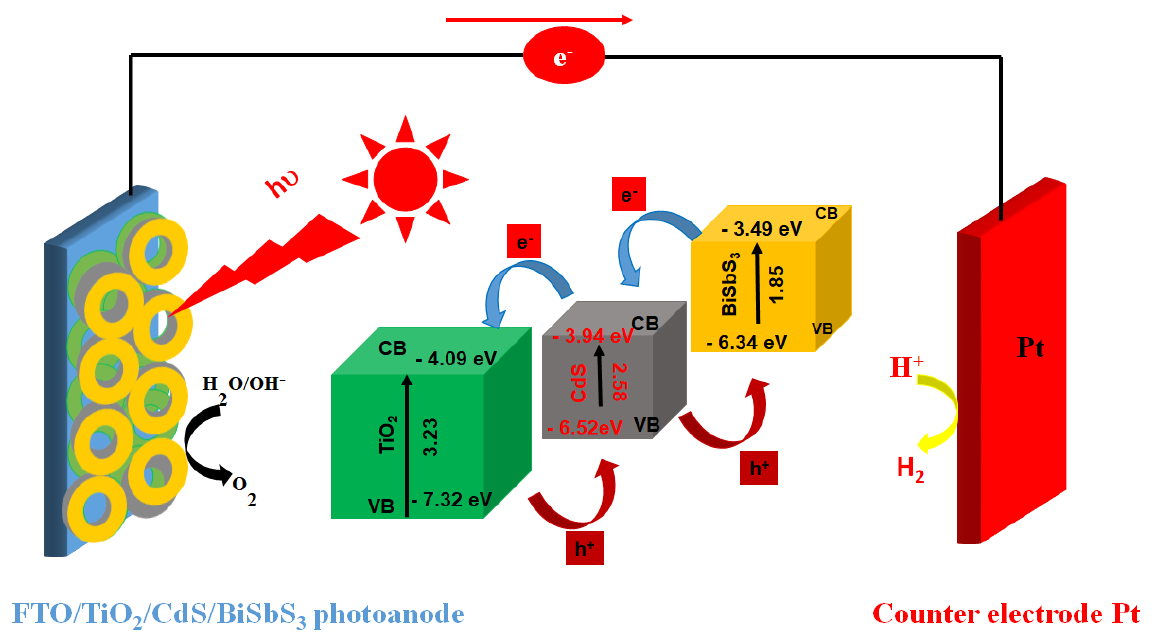
Figure 6. Possible reaction mechanism for efficient charge transfer in TiO 2 /CdS/BiSbS 3 photoanode.